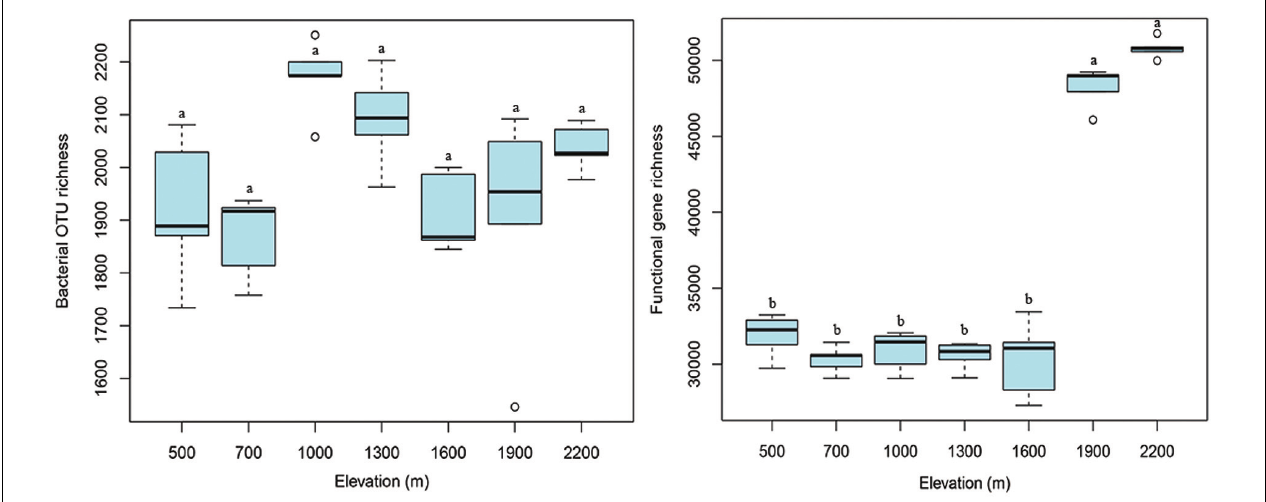
FIGURE 3 | The elevational alpha diversity patterns for bacterial communities and microbial functional genes. Bacterial alpha diversity (OTU richness) exhibited no apparent elevational gradient, whereas microbial functional gene alpha diversity (functional gene richness) showed a sharp increase at 1900 m (treeline ecotone). Different letters indicate significant differences ( p < 0.05).